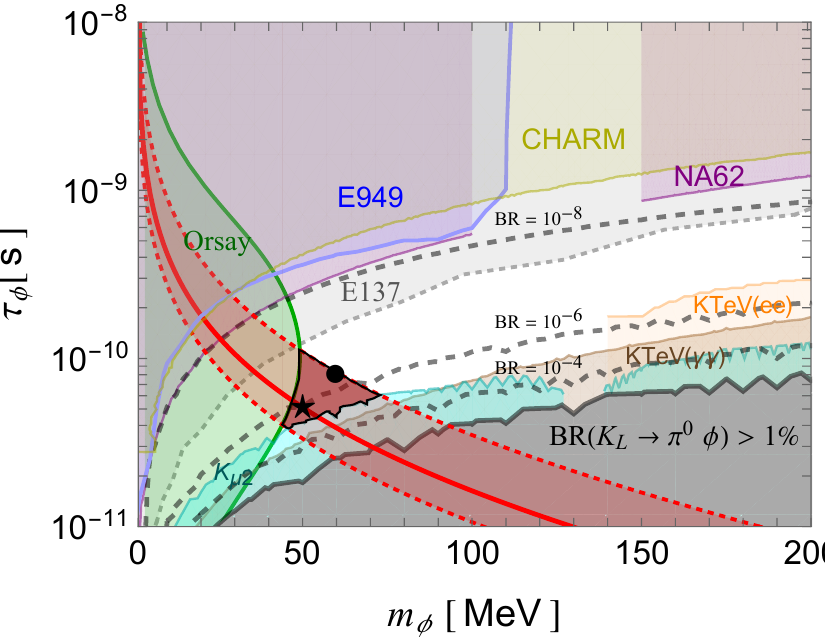
Figure 3 . The parameter space for the e(cid:11)ective model in the m (cid:30) { (cid:28) (cid:30) plane. For each point on the plane, BR( K L ! (cid:25) 0 (cid:30) ) is (cid:12)xed to (cid:12)t to the central value measured by the KOTO experiment. We show contours of BR( K L ! (cid:25) 0 (cid:30) ) = 10 (cid:0) 4 ; 10 (cid:0) 6 ; and 10 (cid:0) 8 in gray dashed lines. Once the value of (cid:15) ‘ is (cid:12)xed to (cid:12)t ( g (cid:0) 2) (cid:22) , the scalar lifetime shrinks to the red shaded region, where the red solid line corresponds to the central value of (cid:1) a (cid:22) and the red dotted lines correspond to the 2 (cid:27) region. The dark red highlighted region can explain both ( g (cid:0) 2) (cid:22) and KOTO anomalies. The cyan, blue, purple, yellow, light orange, brown, green, and light gray shaded regions are excluded at 95% C.L. by the K (cid:22) 2 [37], E949 [38, 39], NA62 [40], CHARM [41], KTeV/E799 ( K L ! (cid:25) 0 e + e (cid:0) ) [42], KTeV ( K L ! (cid:25) 0 (cid:13)(cid:13) ) [43], Orsay [44], and E137 [45] experiments respectively. The gray shaded region is excluded by untagged K L decay